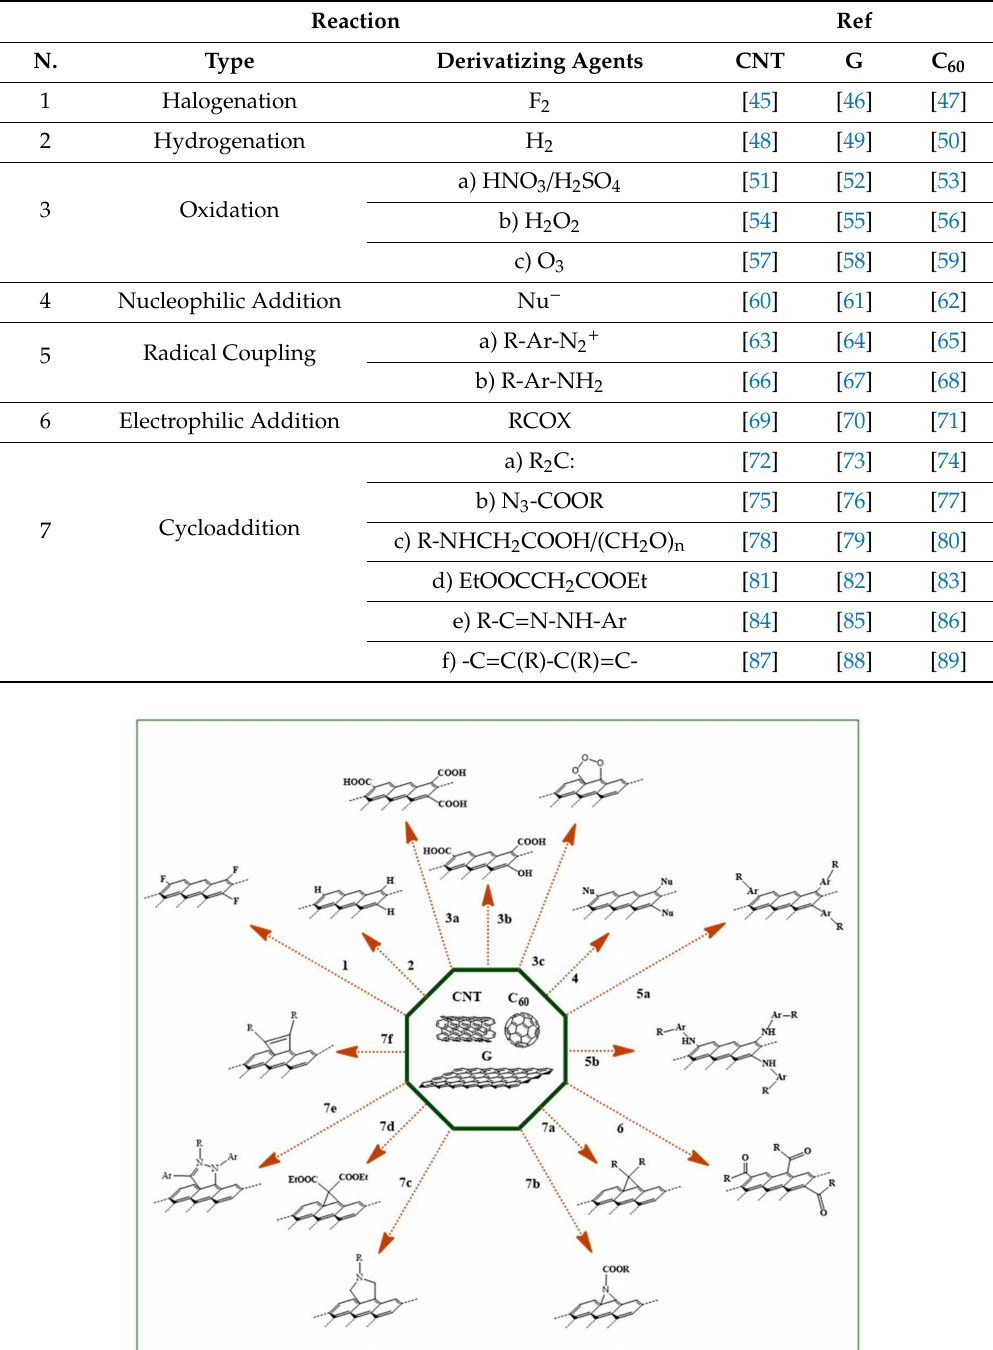
Table 1. Main CN covalent functionalization routes.